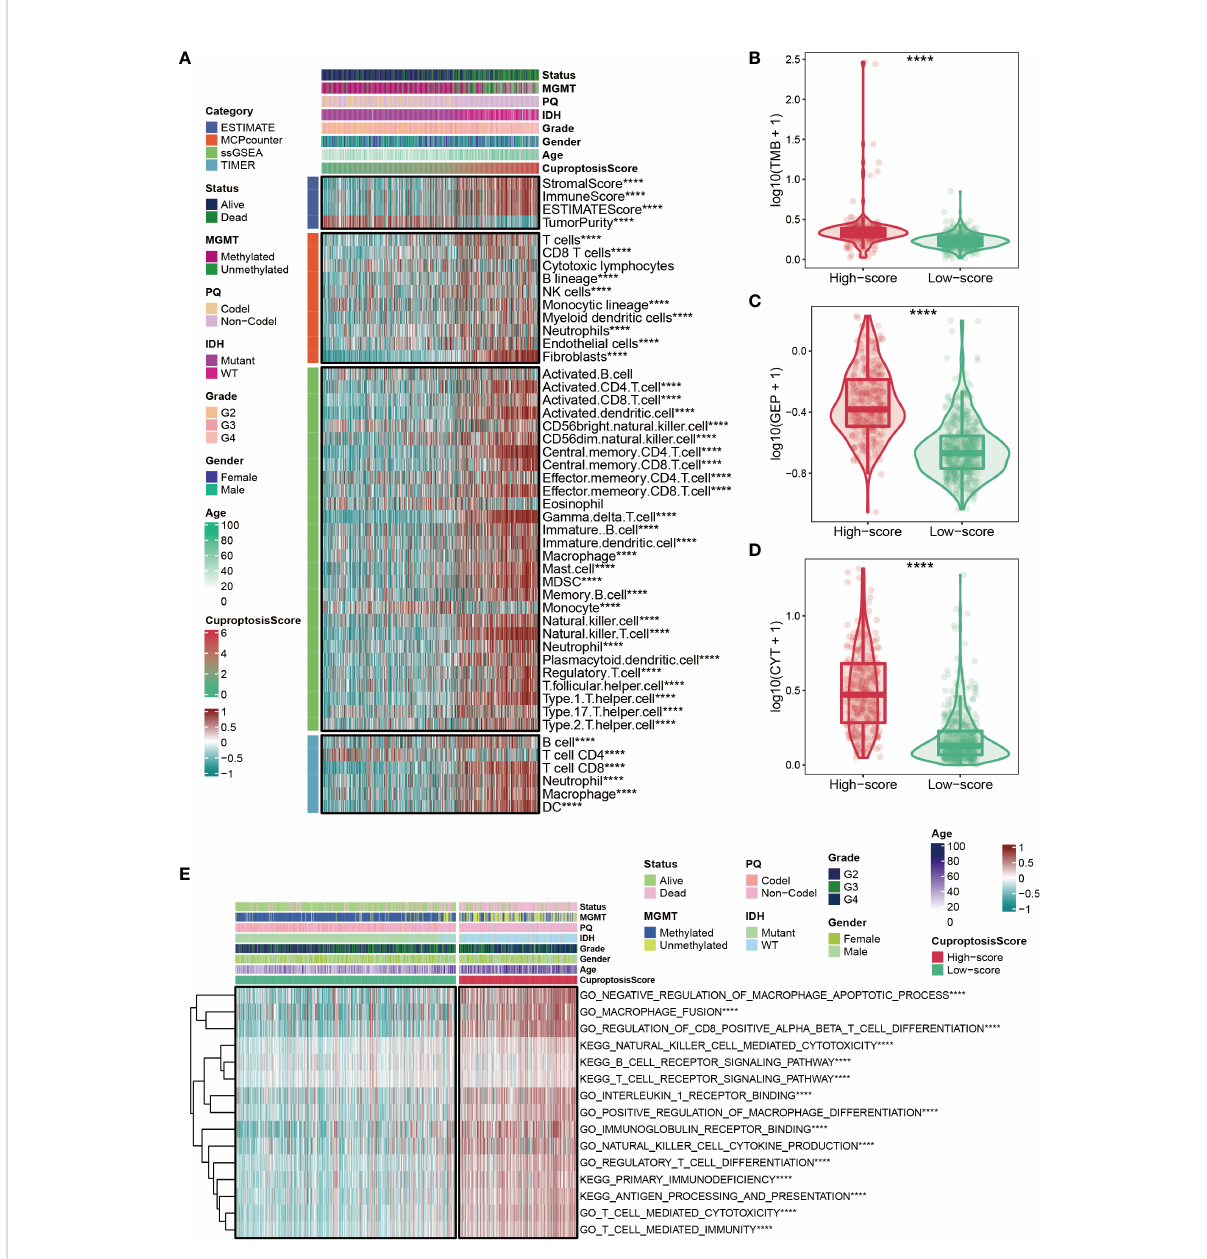
FIGURE 5 Immune status for cuproptosis-signature. (A) The heatmap shows the abundance of in fi ltrating immune cell populations at different CuproptosisScores. (B – D) Glioma patients with high CuproptosisScores had higher levels of TMB (B) , GEP (C) , and CYT (D) . (E) The heatmap shows CuproptosisScores, clinical features, and immune-related pathways based on GSVA analysis. ****P <